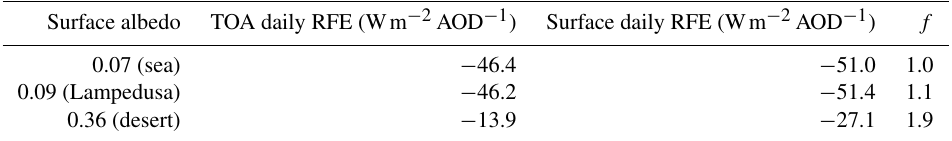
Table 3. TOA and surface daily RFE, as well as the ratio f , as a function of the surface albedo. Surface